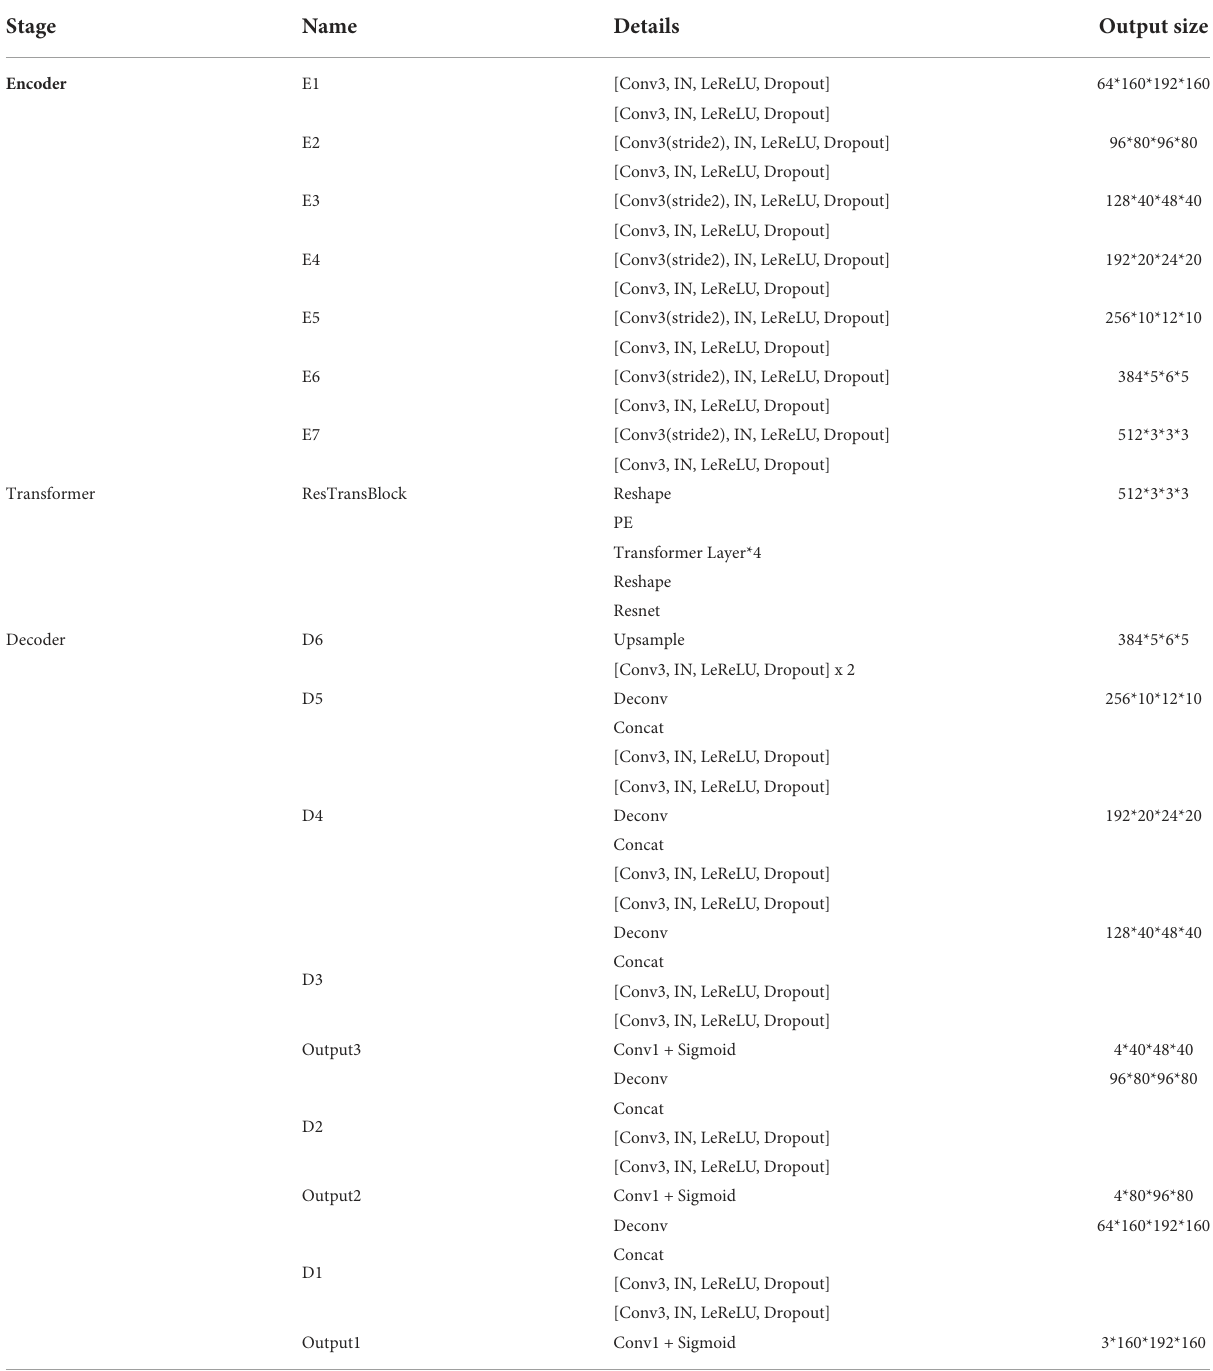
TABLE 1 The detailed structure of proposed generator. Stage